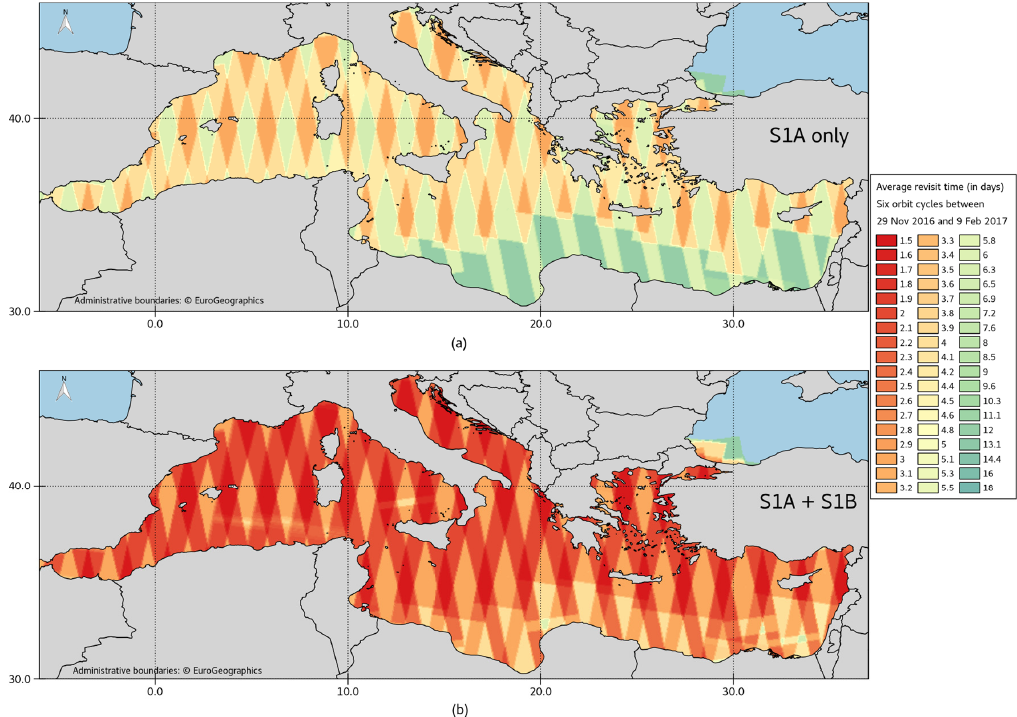
Figure 5. Average revisit time (in days) between consecutive: ( a ) Sentinel-1A acquisitions; and ( b ) Sentinel-1A + Sentinel-1B, from 29 November 2016 to 9 February 2017 (72 days, 6 complete orbit cycles, absolute orbit number from 14,160 to 15,209 for Sentinel-1A, and from 3177 to 4226 for Sentinel-1B; 1381 Sentinel-1A images and 1523 Sentinel-1B images). Calculated with a grid size of 0.05°.